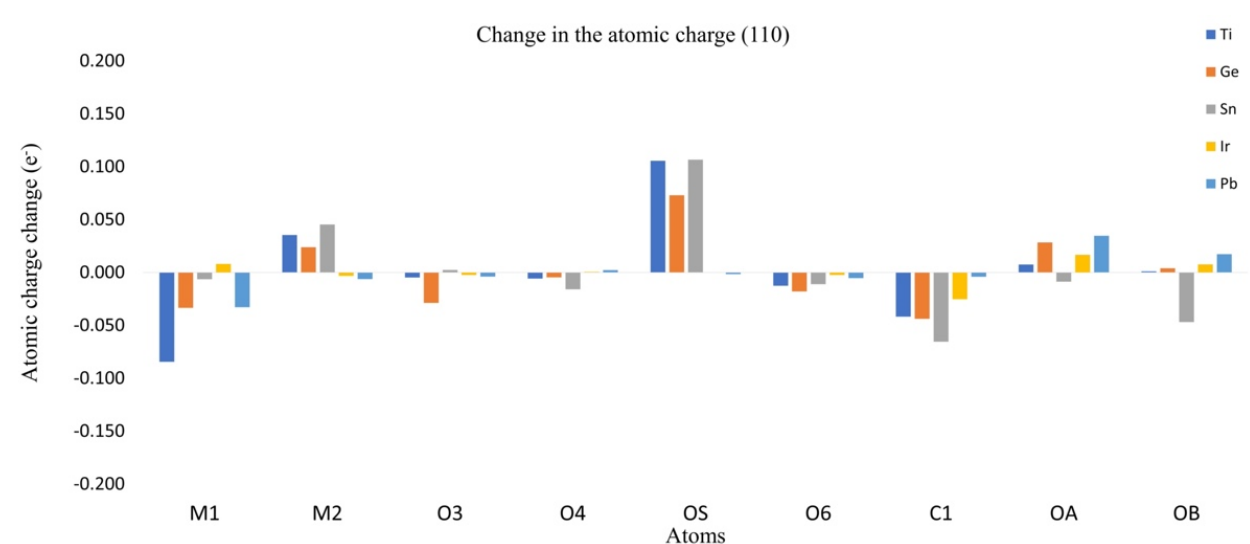
Figure 8. Atomic charge change for plane (110).